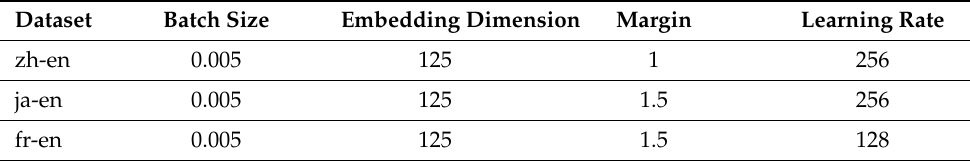
Table 2. The best hyper-parameters for different sub-datasets of DBP15K. Dataset Batch Size Embedding Dimension